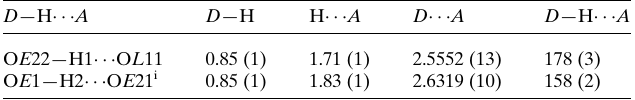
Table 2 Hydrogen-bond geometry (A˚ , (cid:5) ).